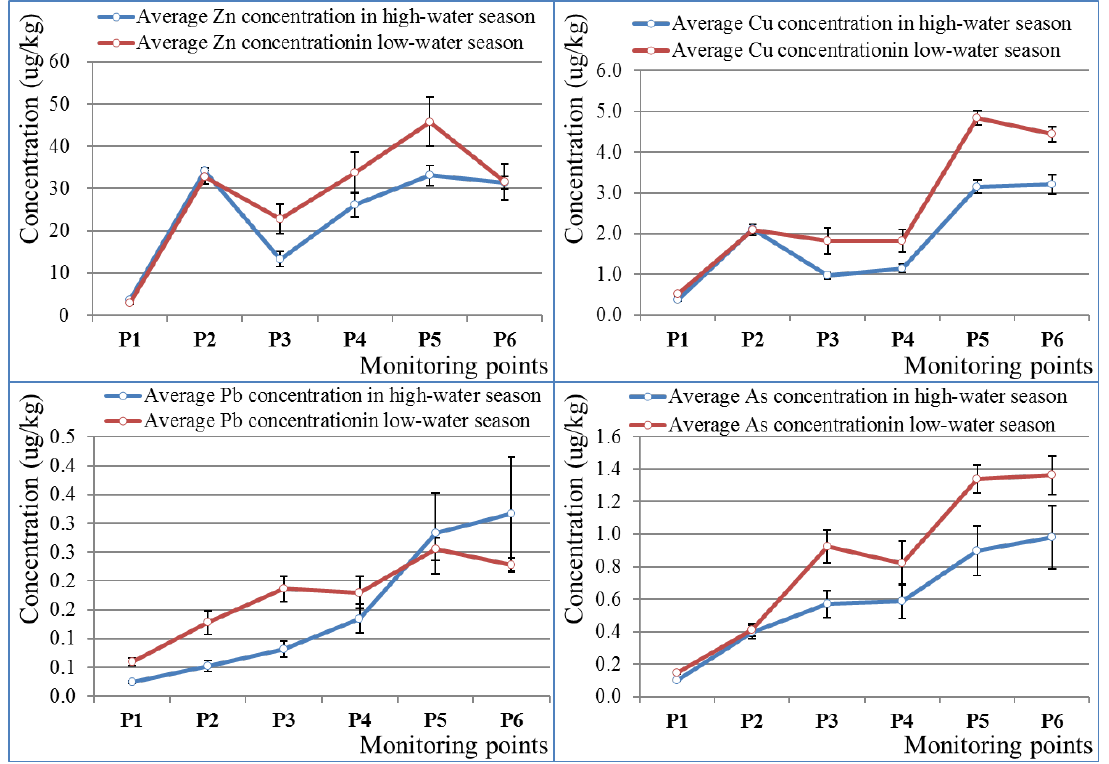
Figure 5. Zn, Cu, Pb and As concentrations along the mainstream Kosaka River both in the high-water season and low-water season. The error bar is plotted by the standard error (SE) of the Zn, Cu, Pb and As concentrations in the high-water season (April 2011, April 2014, and May 2015) and low-water season (November 2012, October 2013, and October 2015).